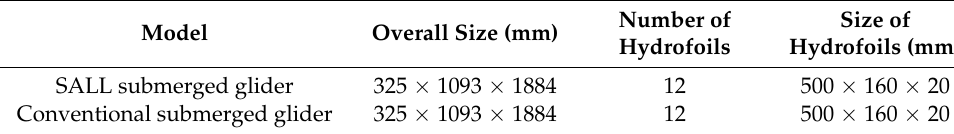
Table 6. The geometric dimension of the SALL submerged glider and conventional submerged glider.